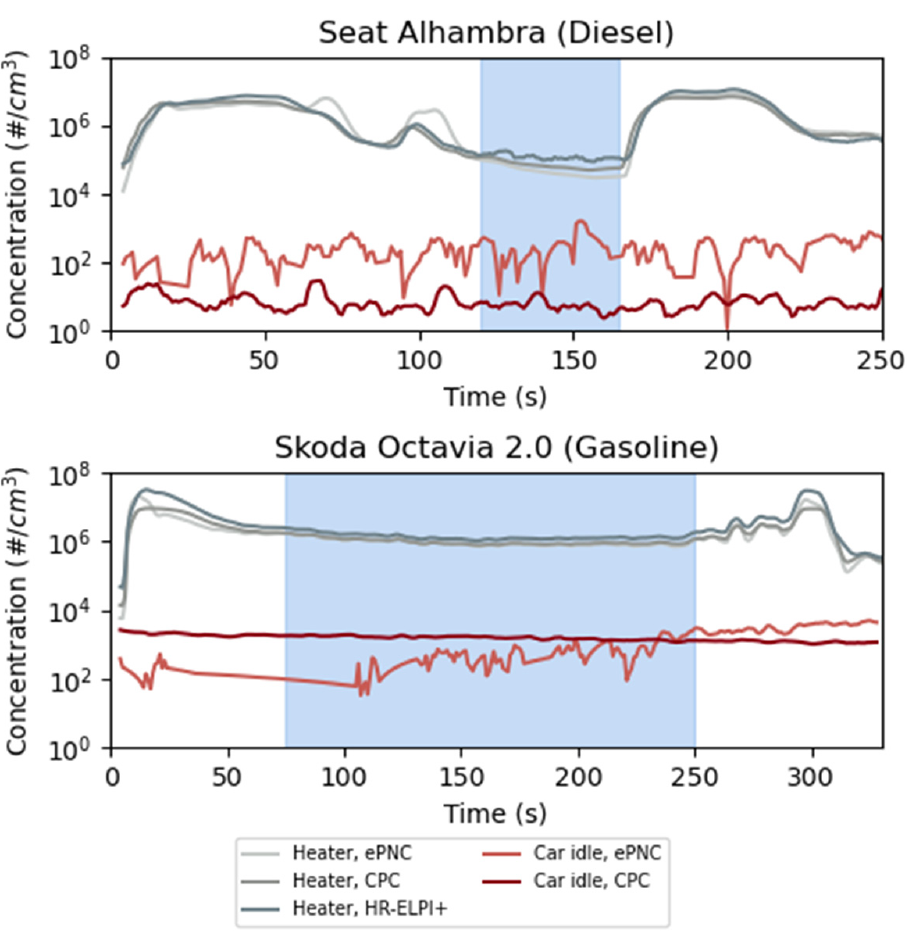
Figure 2. Time-series of particle number concentrations during auxiliary heater operation. Particle number concentrations during vehicle engine idling are also presented, to give perspectives of the magnitude of AH emissions. The blue background indicates the period of the plateau where the emission was fairly stable, and from which the results for the comparison presented in Figure 3 were calculated. During the idle measurement, the particle number concentration was close to the detection limit of the ePNC, causing large variation between the ePNC and the CPC.